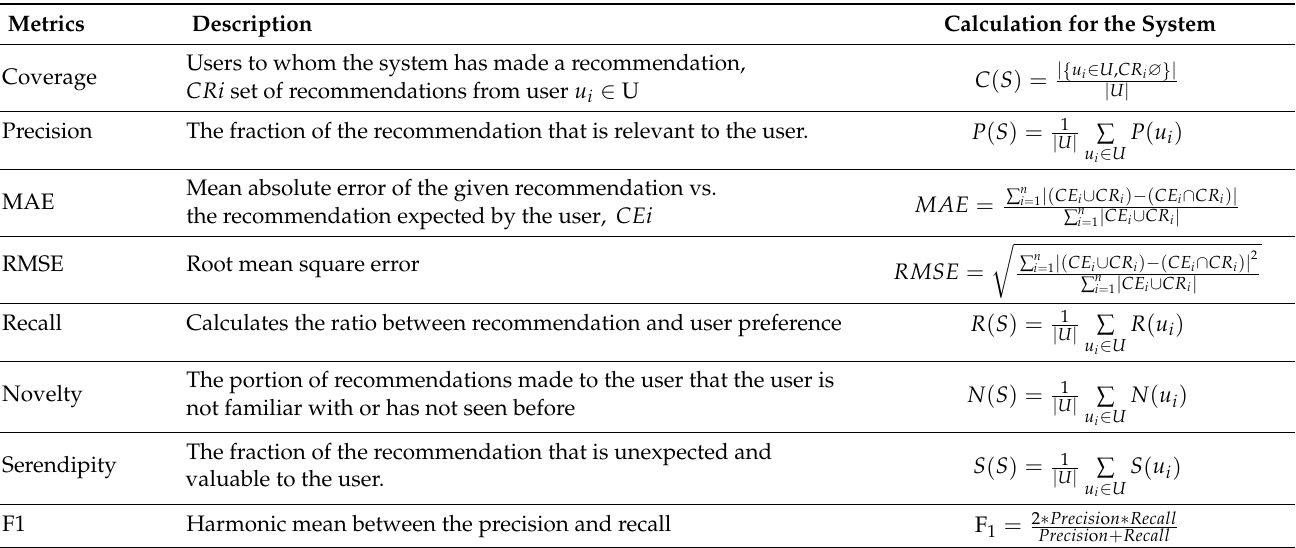
Table 5. Evaluation metrics for recommendation